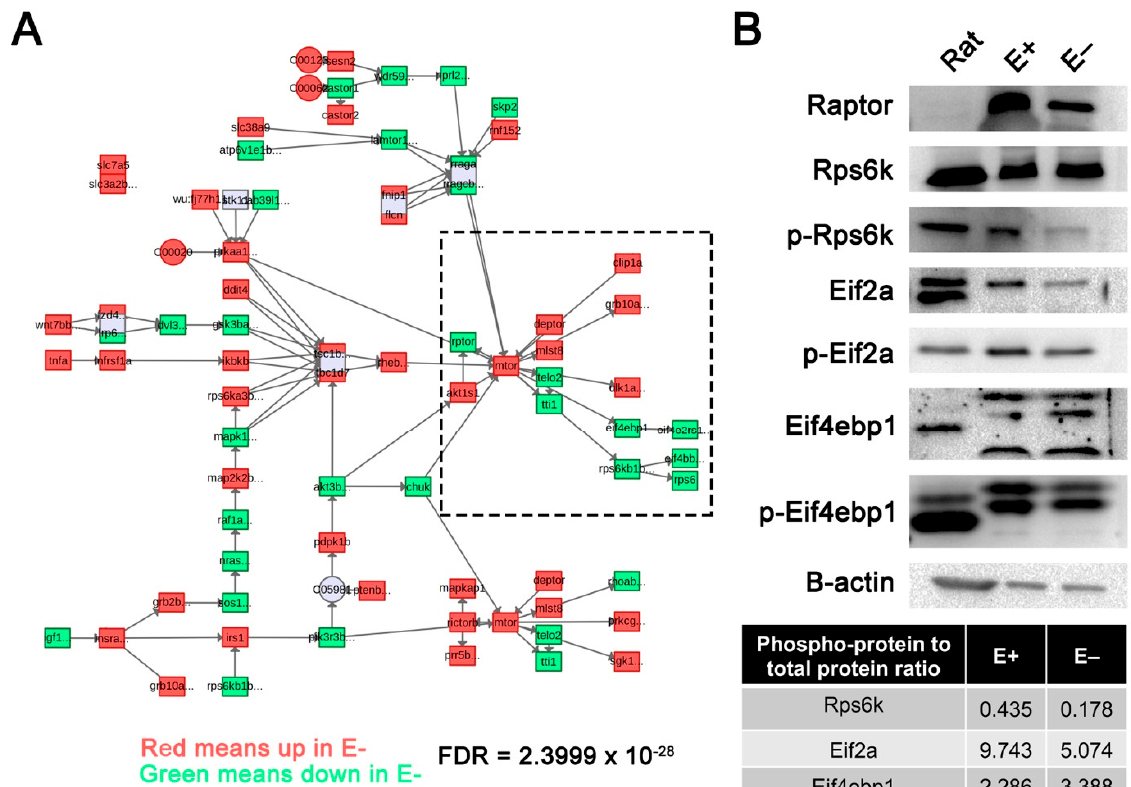
Figure 5. Mechanistic target of rapamycin (mTOR) signaling pathway disrupted in 24 hpf E– embryos. ( A ) E+ and E– embryos at 24 hpf metabolomic data acquired previously were integrated with gene expression profiles using MetaboAnalyst to generate network profiles. The mTOR signaling pathway was significantly enriched with both metabolites and genes expressed in 24 hpf E– embryos. Red boxes or circles represent increased, while green boxes represent reduced metabolite or gene expression, respectively, in E– relative to E+ embryos. ( B ) mTOR complex 1 (mTORC1)-associated proteins including Raptor, Rps6k, Eif2a and Eif4ebp1 were evaluated by activity determined by phosphorylation status in pooled protein extracts of rat liver (positive control), E+ and E– embryos ( n = 30 embryos/pool) at 24 hpf. Phospho-protein (p-) to unphosphorylated protein ratio is calculated for the representative lanes shown.